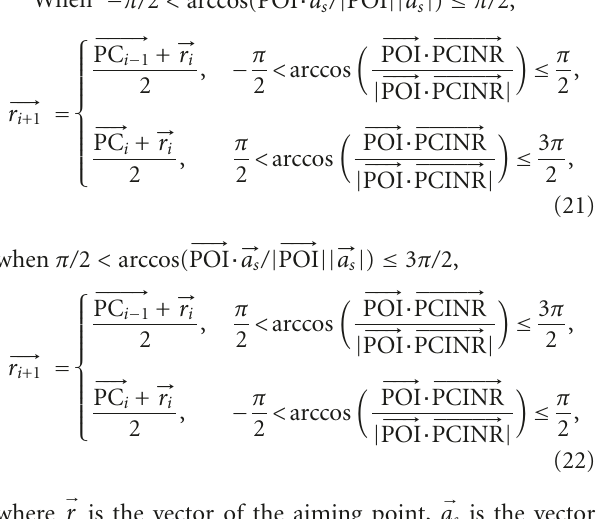
Figure 12: The mean distance/best case/worst case with di ff erent random points sets in half distance